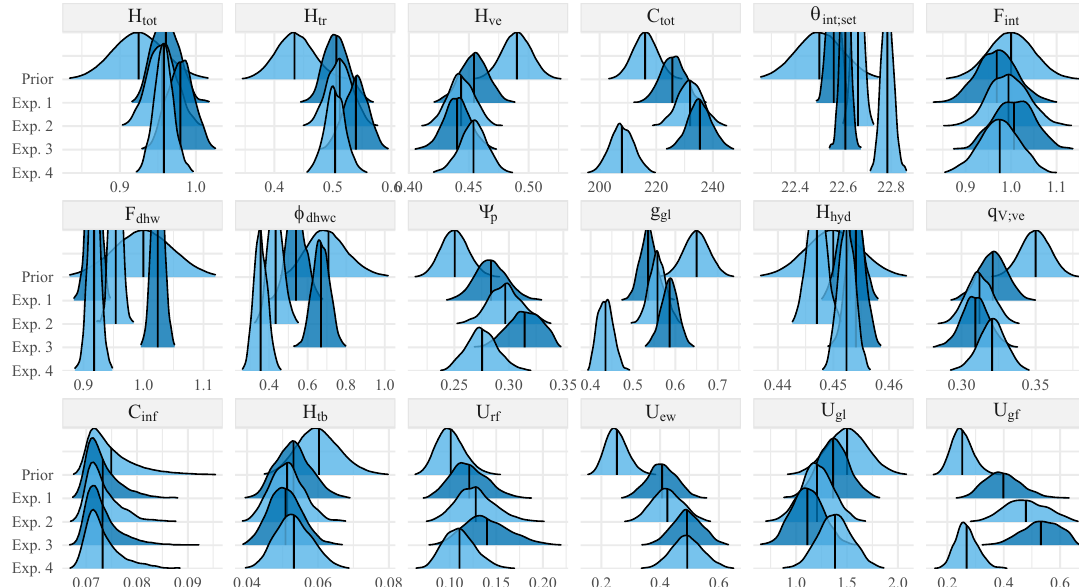
Figure 12. Parameter probability density distributions showing the prior model and HMC sampled posteriors for the four experiments. Experiment 1: DHW based on reference measurements. Experiment 2: DHW based on measured total cold water use. Experiment 3: DHW based on individual DHW measurements per apartment. Experiment 4: The standard deviation of the measured indoor air temperature divided with 3 (DHW is the same as in Experiment 3). Vertical lines show mean values. Densities are scaled per parameter such that the mode of the prior has a relative height of